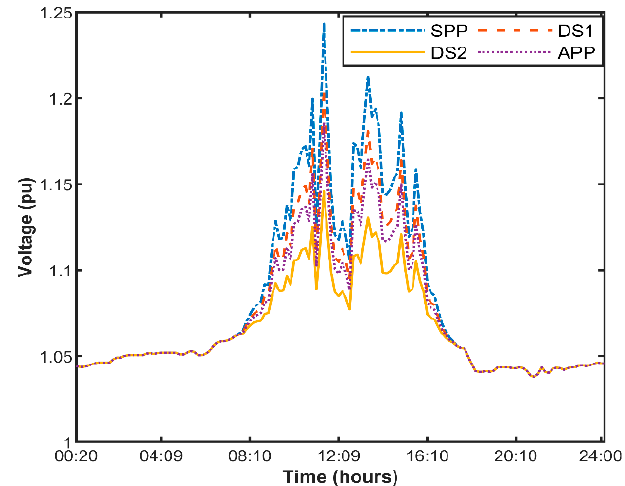
Figure 11. Loading profiles for winter, summer and ∆ Max days.